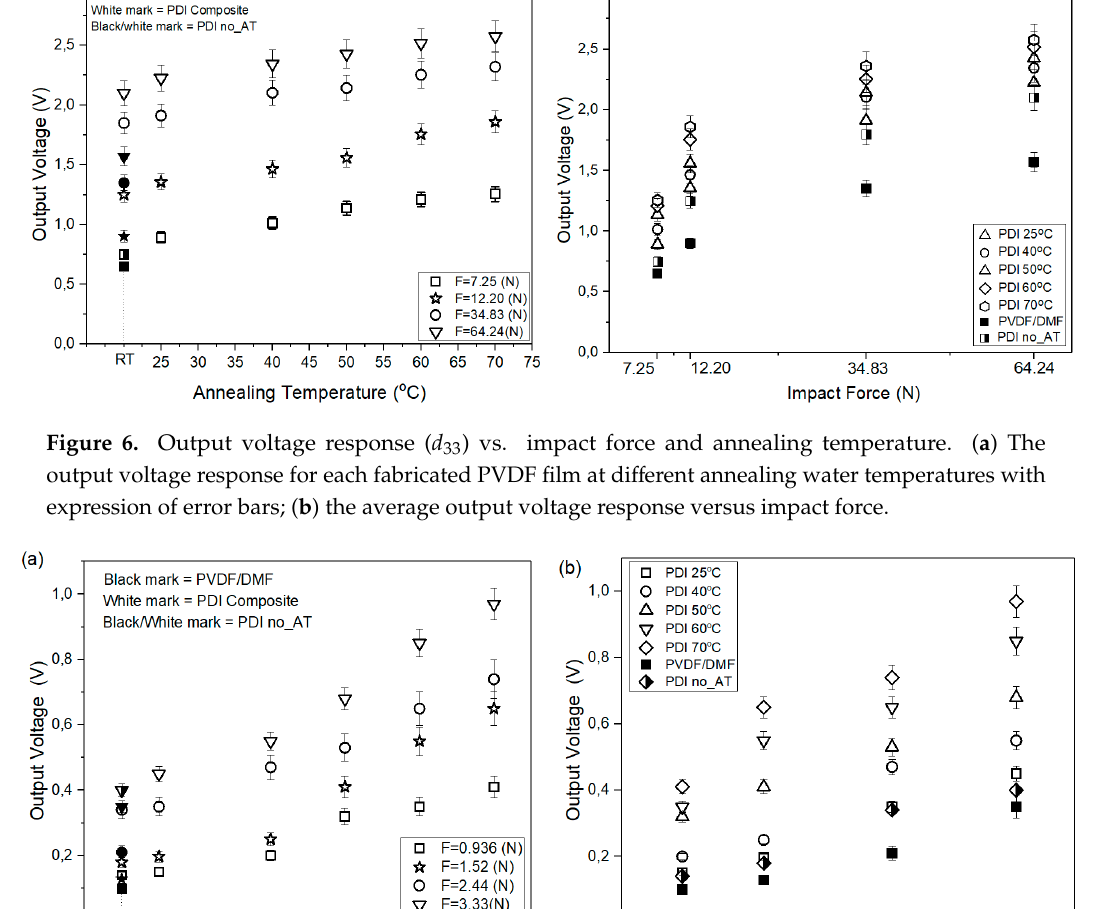
Figure 7. Output voltage response ( d 31 ) vs. extraction force and annealing temperature. ( a ) Di annealing water temperature applied to the film for searching d31; ( b ) di ff erent stretch force applied to the film for searching